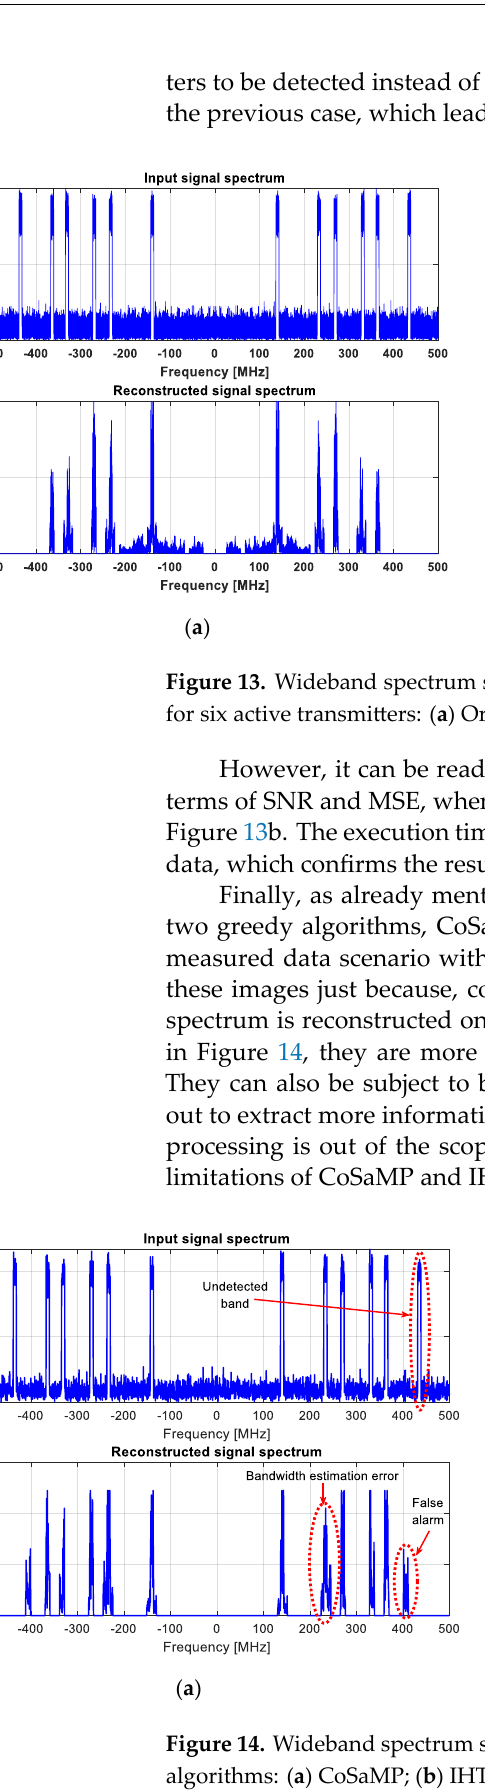
( b ) Figure 12. Wideband spectrum sensing results provided by the proposed reconstruction algorithm for two active transmitters: ( a ) Original measured data; ( b ) Reduced data. For the scenario with six active transmitters, i.e., 12 active frequency bands (Figure